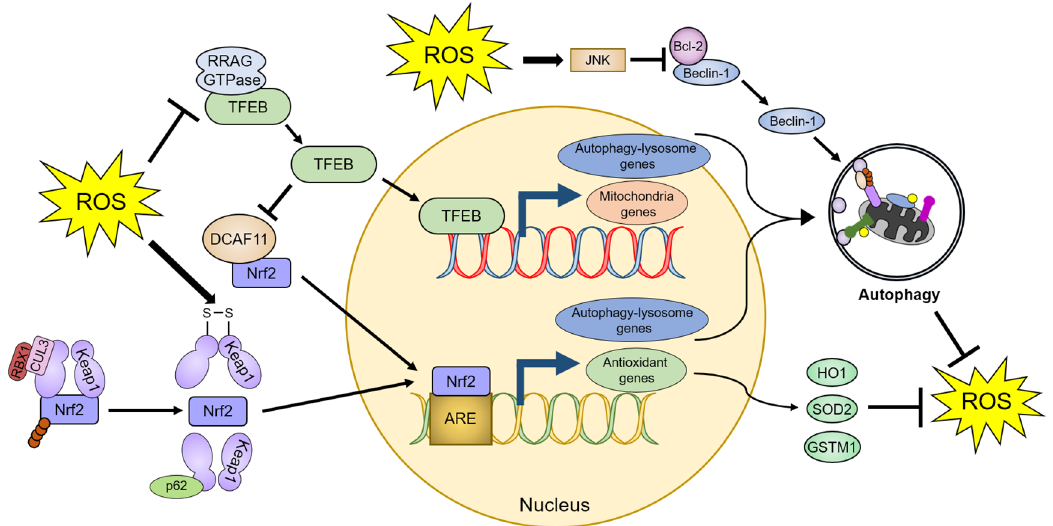
Figure 3. Autophagy-mediated regulation of ROS homeostasis. ROS promote autophagic activity by dissociating TFEB from RRAG GTPase and Beclin-1 from Bcl-2. ROS also activate Nrf2 through a conformational change in Keap1, leading to the dissociation of the Keap1-Nrf2 complex. Therefore, cells can ameliorate increased oxidative stress by the TFEB- and Nrf2-dependent upregulation of autophagic activity and antioxidant proteins. The detailed defense mechanisms are described in Section 4. TFEB: transcription factor EB, DCAF11: DDB1 and Cul4 associated factor 11, RBX1: